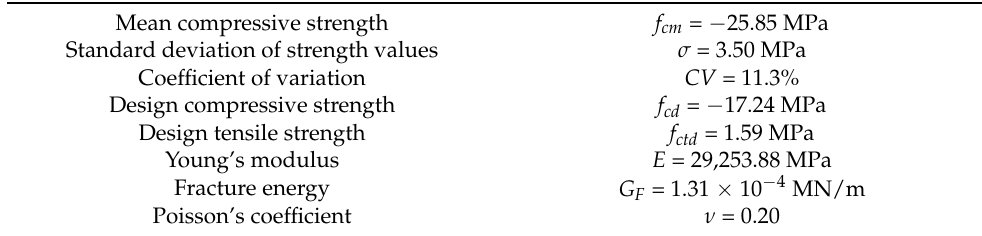
Table 1. Mechanical properties of concrete.